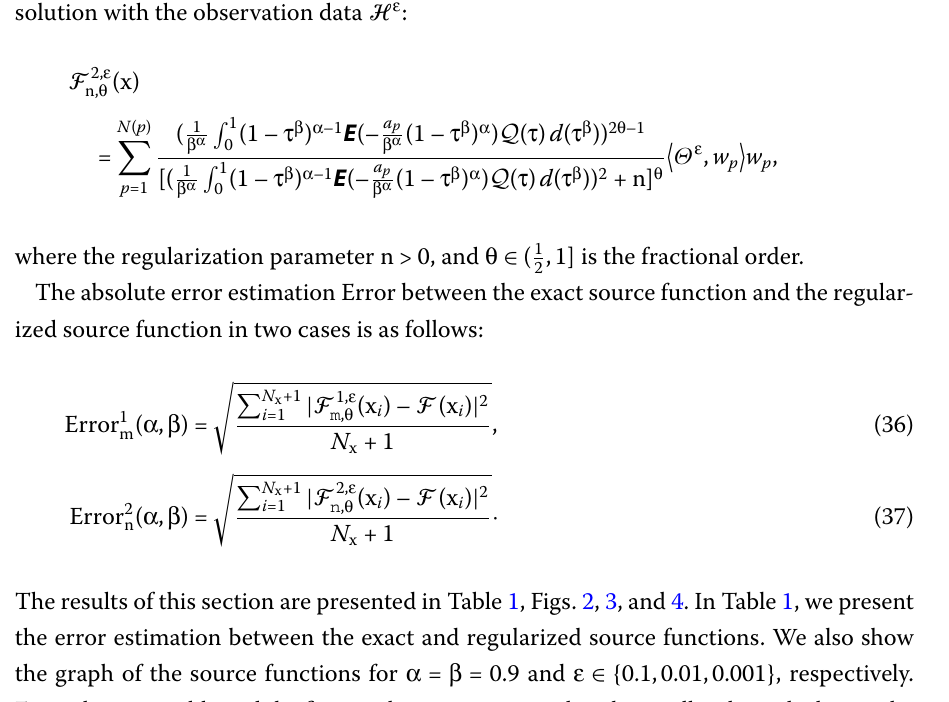
Table 1 The error estimation between the exact and regularized source functions for x ∈ [0, π ] Error 1,2 m , n ( α , β ) N x = 40, N ( p ) = 10, m = n = 5, c = 0.1, θ = 0.3 ε : 0.1 0.01 0.001 Error 1 m (0.1,0.1) 4.622039876238438 0.813894458788424 0.034641254935990 Error 2 n (0.1,0.1) 0.080884577605506 Error 1 m (0.5,0.5) 0.661448882414577 0.036340894224658 Error 2 n (0.5,0.5) Error 1 m (0.9,0.9) Error 2 n